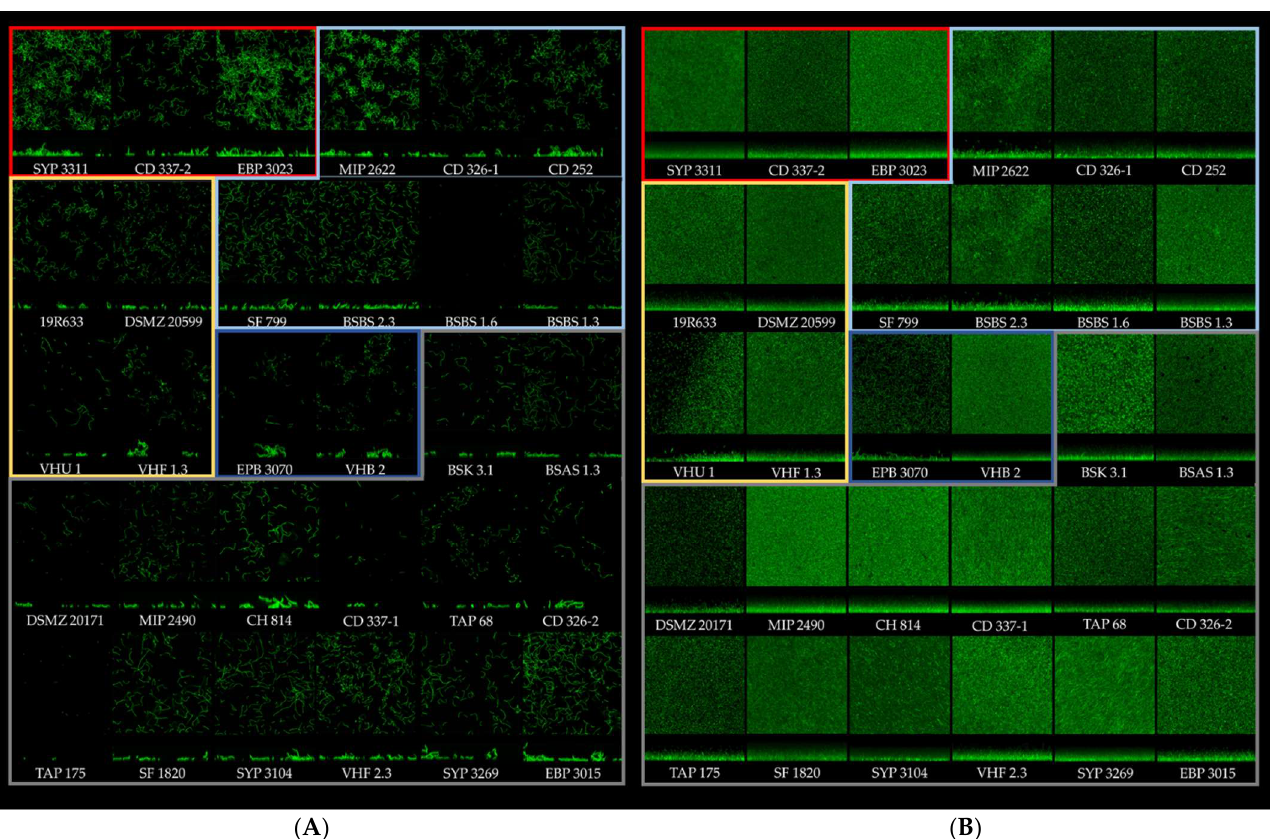
Figure 4. IMARIS projection from CLSM images of each strain at t = 2 h ( A ) and t = 24 h ( B ). Each cluster is framed by its clustering color code from Figure 3: red, cluster 1; light blue, cluster 2; yellow, cluster 3; dark blue, cluster 4; gray, cluster 5.